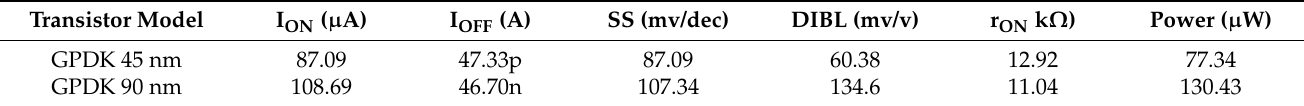
Table 3. Extracted voltage-current characteristic results of MOSFET GPDK 90 and 45 nm